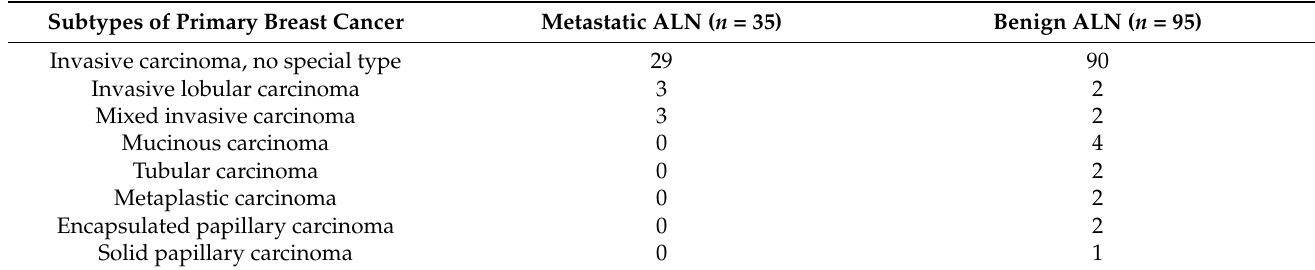
Table 2. Subtypes of primary breast cancer.